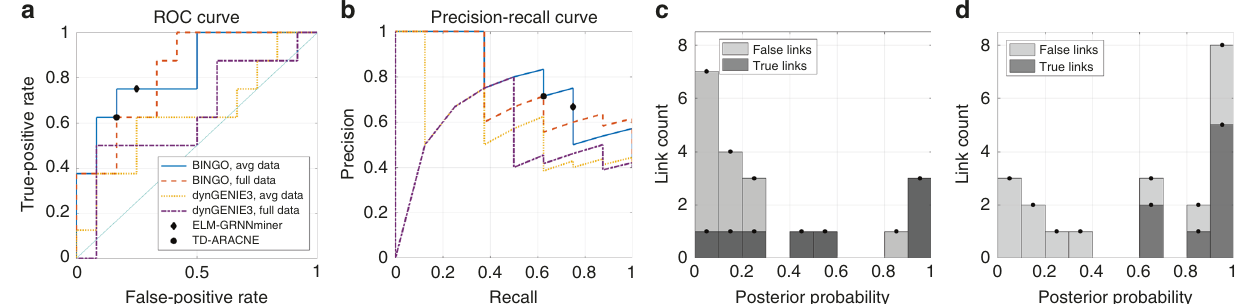
Fig. 3 Results for in vivo dataset IRMA. The ROC ( a ) and precision-recall ( b ) curves for BINGO and dynGENIE3 using either all nine time series, or the two averaged time series together with predictions from the ELM-GRNNminer (obtained from ref. 5 , Fig. 4) and the TD-ARACNE (from ref. 43 , Fig. 5). c – d The histograms of posterior probabilities of all links for the averaged ( c ) and full ( d ) IRMA data. In the average data case, the prediction with three true positives and no false positives is obtained with threshold between 0.86 and 0.97. The best prediction with fi ve true and one false positive is obtained with threshold between 0.25 and 0.45. In the full data case, the likely predictions are six true and four false positives with threshold between 0.66 and 0.85, or eight true positives (all) and fi ve false positives with threshold 0.39 and